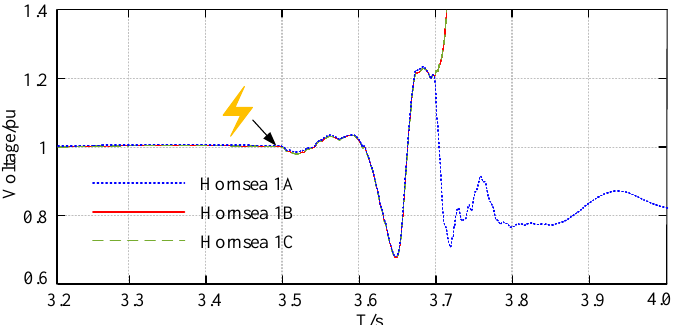
Figure 9. Response of Hornsea wind farm under improved control.